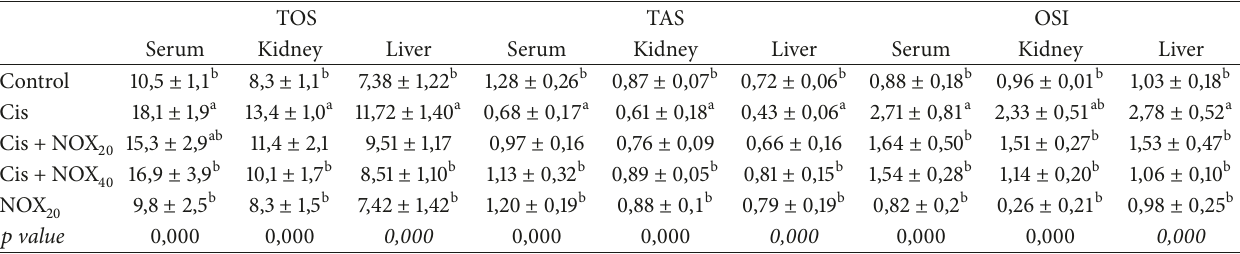
Table 2: Effects of cisplatin (7mg/kg), naringenin oxime (20mg/kg), Cis + NOX 20 , and Cis + NOX 40 on TOS, TAS, and OSI in serum, kidney, and liver of